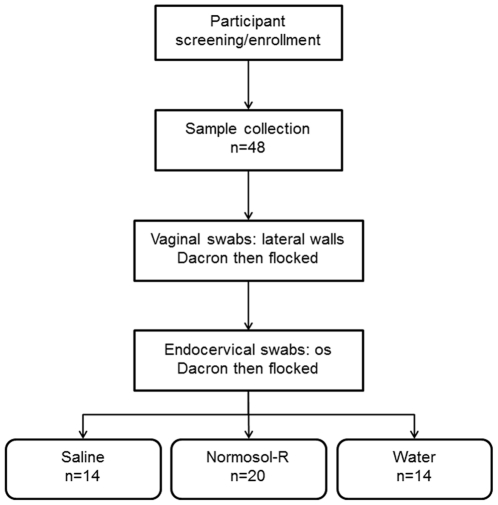
Sample collection algorithm.Sample collection proceeded from the introitus to the cervix. A Dacron swab was rolled 360° along the vaginal lateral wall. A flocked swab was rolled 360° along the opposite vaginal lateral wall. After vaginal swabs, endocervical swabs were taken with first a Dacron swab and then a flocked swab inserted into the cervical os and turned 360°. Finally, the women were randomized to have a CVL collected with 10 ml of saline, Normosol-R, or tap water. Samples were processed as described in the Methods section.